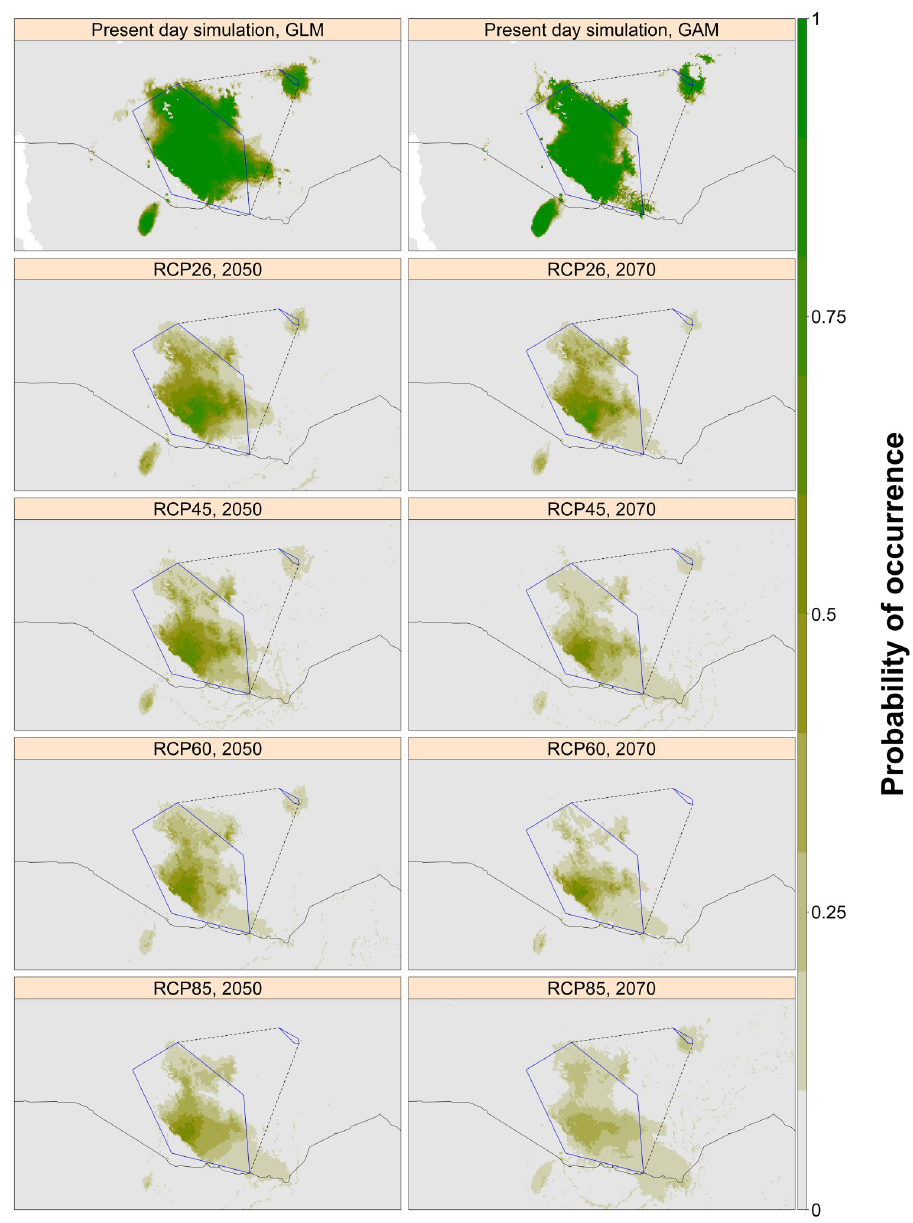
Fig 5. Projected current and future potential range for the White-tailed Swallow, based on climate-only SDMs. Predictions for the four IPCC RCPs are presented in two future dates, 2050 and 2070. Each panel represents the mean probability of occurrence under each scenario, averaged across six GCMs and the three best-performing model algorithms (MaxEnt, GLM and GAM) under current conditions, according to k -fold LOOCV AUC. Dark green shows areas with a high probability of climatic suitability, fading through brown to grey, which shows areas with a low probability of climatic suitability. The blue polygon shows convex hulls fitted around the White-tailed Swallow’s current distributions in the core range and on the Liben Plain, whilst the dashed line shows the complete hull if these two populations are considered to be continuous. International borders are plotted using the ‘ wrld_simpl ’ dataset available in the ‘ maptools ’ package in R [47,